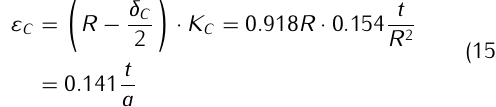
Figure 2. Tomasz Wierzbicki’s flattening cross-section model for pipe bending